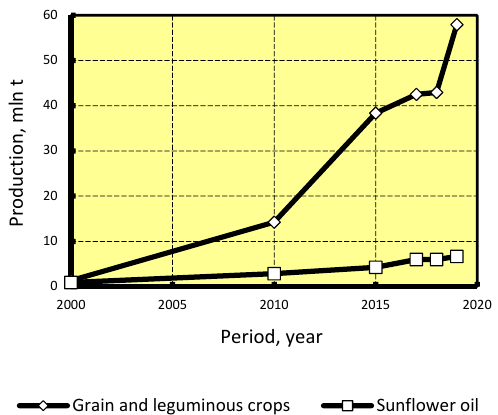
Figure 4. Grain and sunflower oil export history.